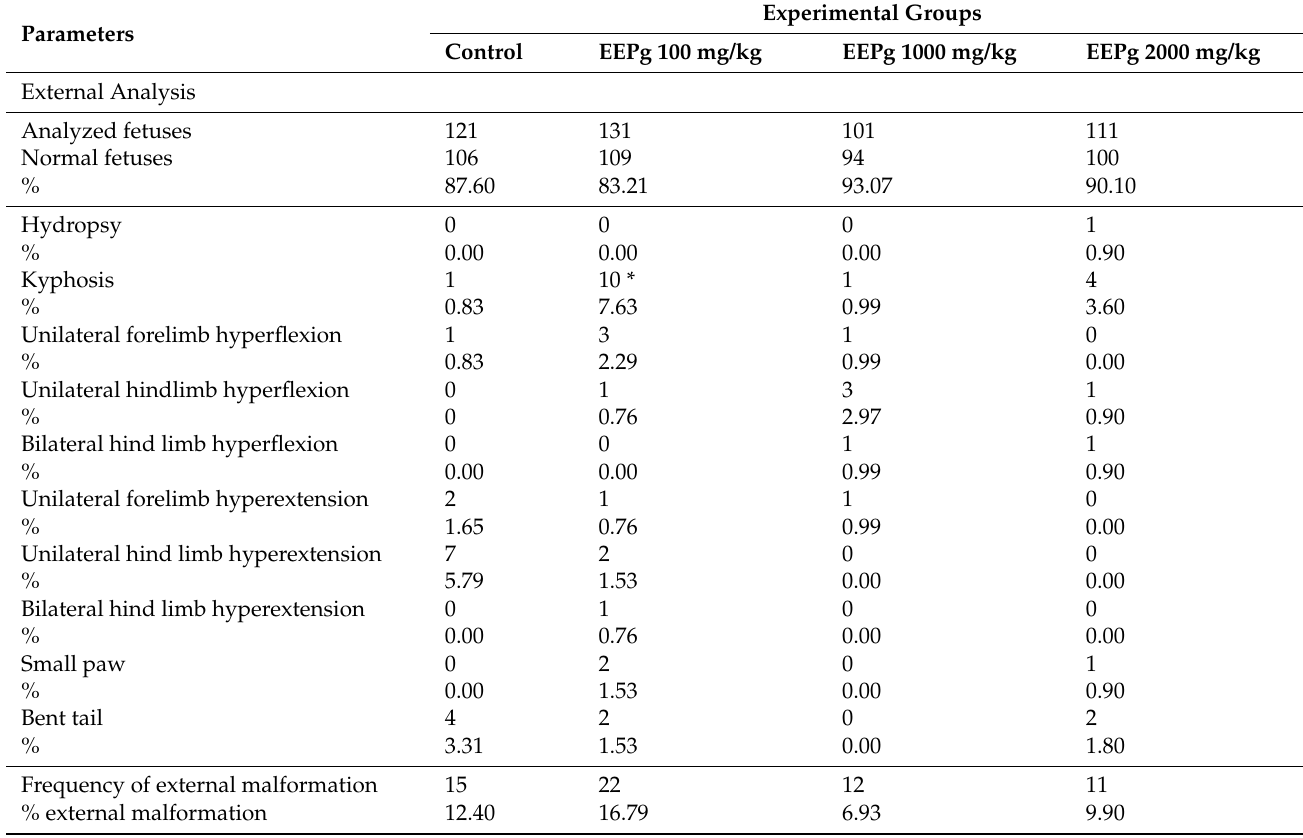
Table 5. Absolute number and percentage of external malformations found in the offspring of females treated with the ethanolic extract of P. glabratum (EEPg).